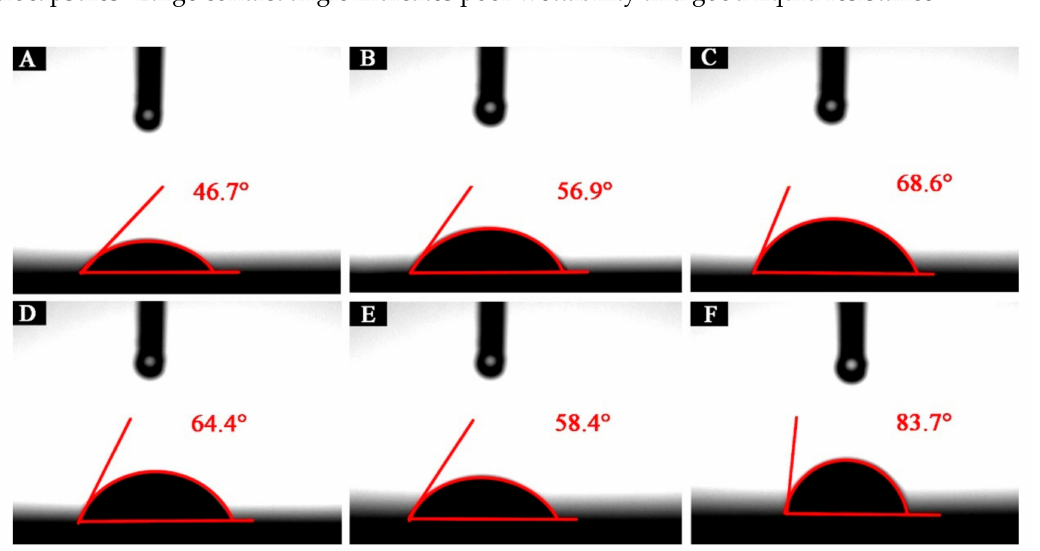
Figure 10. Photographic images of distilled water-contact angle measurements of the 0.58:1 microcapsule–primer coated surface. ( A ) 0%; ( B ) 5.0%; ( C ) 10.0%; ( D ) 15.0%; ( E ) 20.0%; ( F )